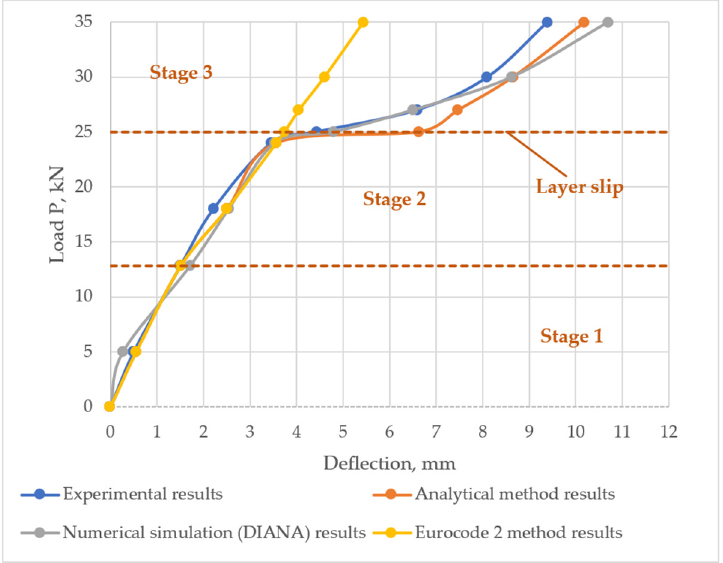
Figure 16. Comparison of the experimental and theoretical deflection of the prefabricated monolithic slab.